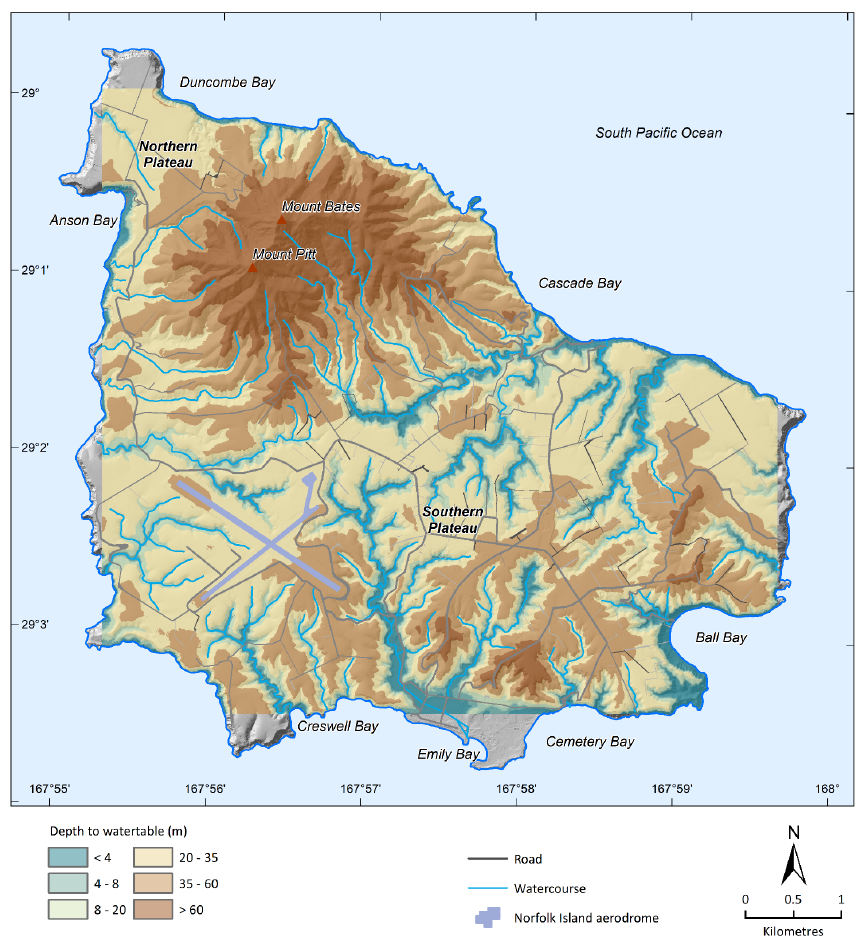
Figure 6. Depth to groundwater. Surface derived from data presented in companion paper Hughes et al. [3].